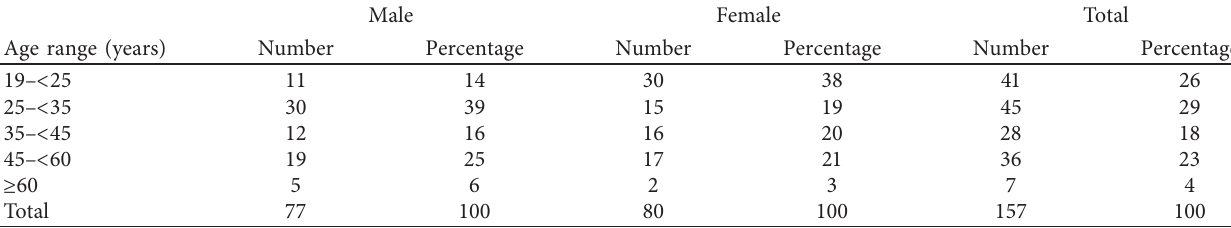
Table 1: Age range in years and gender distribution of the participants.